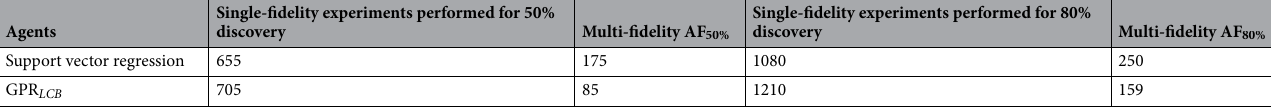
Table 2. Acceleration factor of multi-fidelity agents in in-tandem acquisitions. For each row, we highlighted the agents used, the experiments performed by single-fidelity agents to achieve 50% and 80% discovery, and the acceleration factor (AF) of the multi-fidelity agents. The AF’s are the reduction in number of experiments performed.